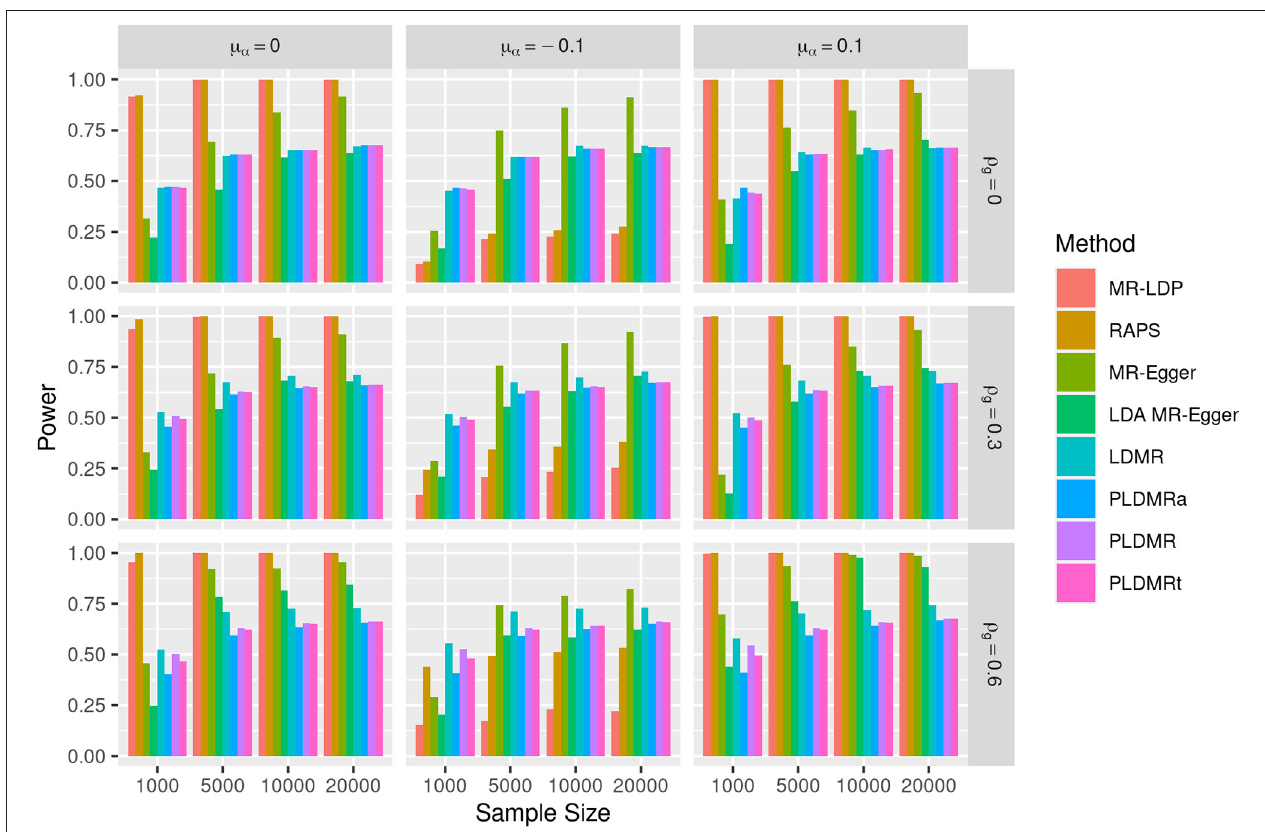
FIGURE 2 | Bar plot of the powers of all methods under the alternative hypothesis of H 1 : β = 0.05. Sample size n = 1,000, 5,000, 10,000, 20,000, the number of genetic variants m = 25, and σ α = 0.1. µ α = 0, − 0.1,0.1 represents the mean of pleiotropic effect and ρ g = 0,0.3,0.6 stands for the relative strength of LD between the genetic